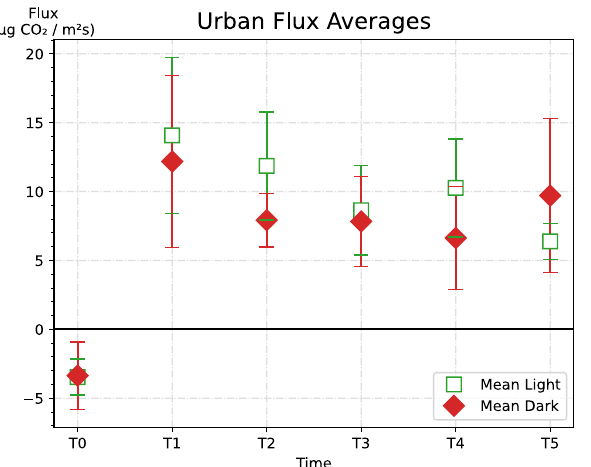
Figure 1. Urban flux averages by dark or light cyanobacterial crust. Error bars represent standard error of the mean.